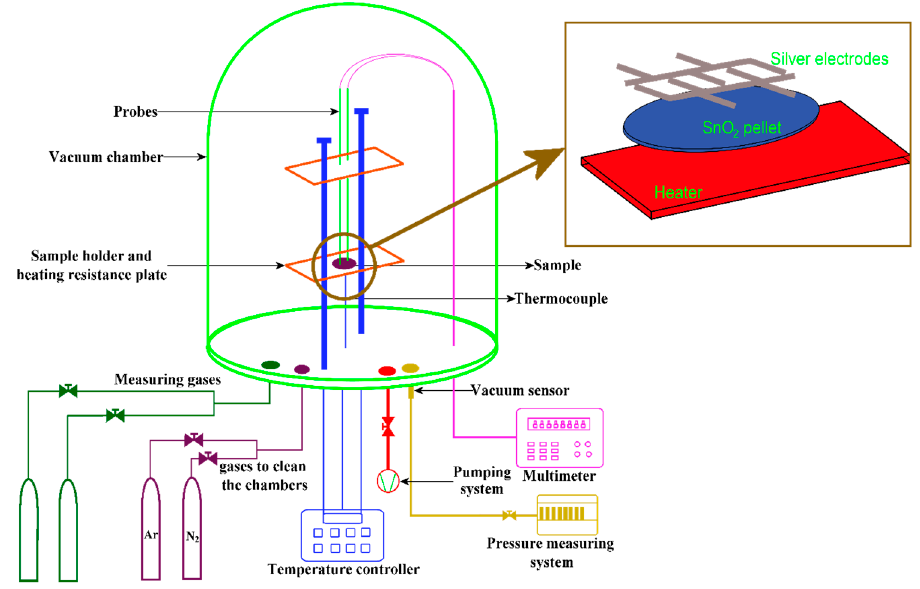
Figure 1. Gas sensing system.